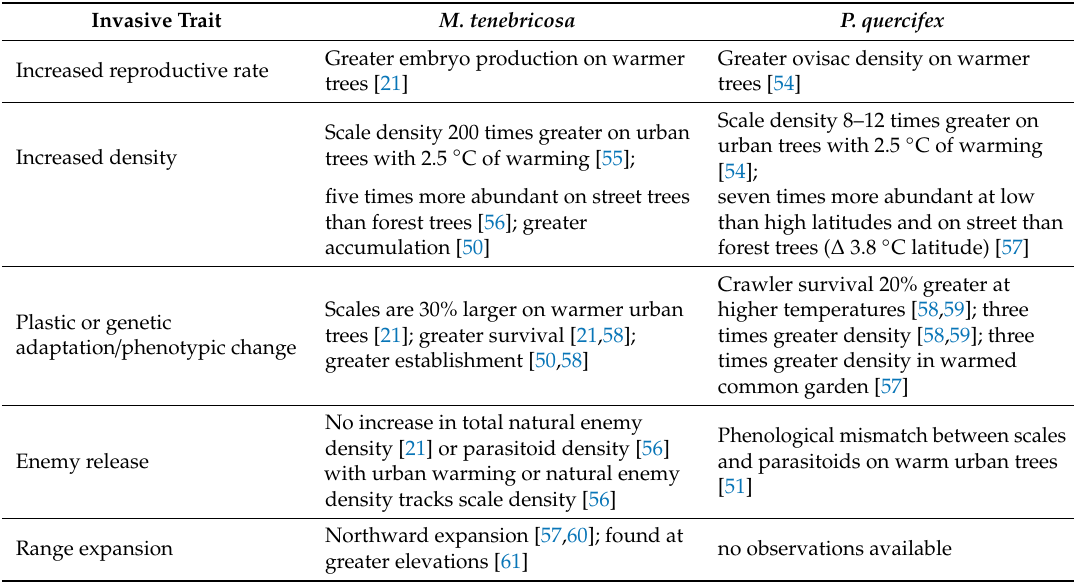
Table 1. Summary of the e ff ects of urban warming on gloomy scale ( Melanaspis tenebricosa ) and oak lecanium scale ( Parthenolecanium quercifex )